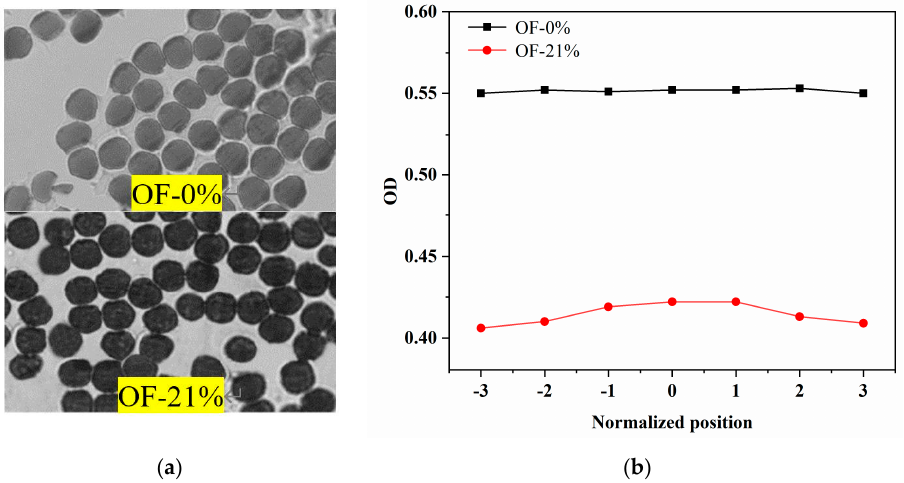
Figure 3. The translucency of the cross-section of the fine denier, PAN pre-oxidized fiber by optical microscope of ( a ) cross-sectional images (the diameter of each filament for pre-oxidized fiber was about 7 µ m) and ( b ) optical